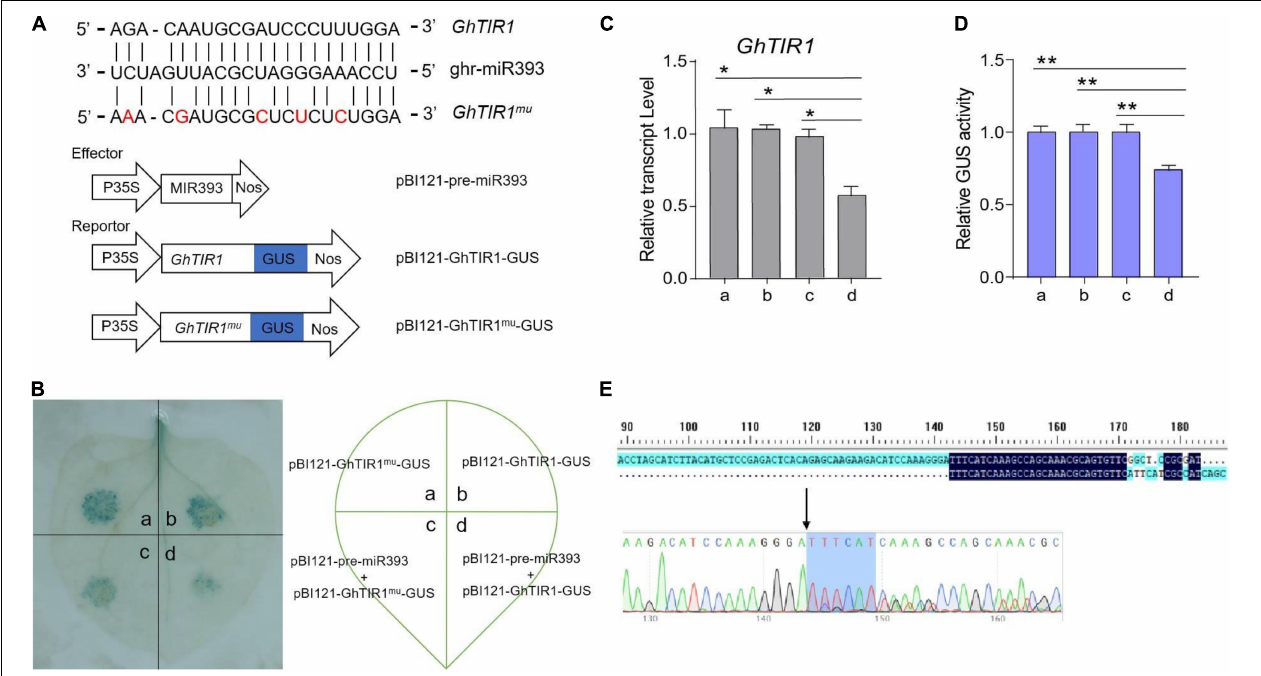
FIGURE 3 | Analysis of directed GhTIR1 degradation by ghr-miR393 via a post-transcriptional process. (A) Construction of the effector and reporter vectors. Red letters represent the bases mutated without changing the amino acid sequence. (B) GUS staining with different vectors. (C) Relative expression of GhTIR1 from panel (B) . (D) Relative GUS activity from panel (B) . (E) The 5 (cid:48) RLM-RACE analysis of PCR products. The error bars indicate the SD of three biological replicates. Statistical significance was determined by Student’s t -test: * P < 0.05, ** P <